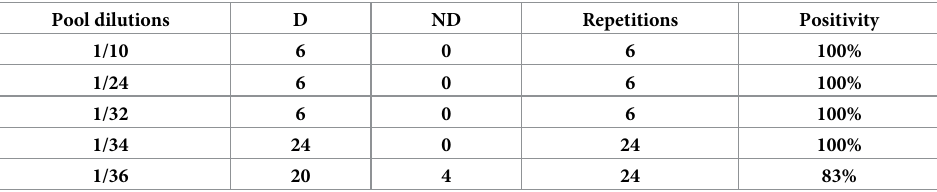
Positive samples are consistently detected when diluted with up to 33 negative samples. D: detectable. ND: not